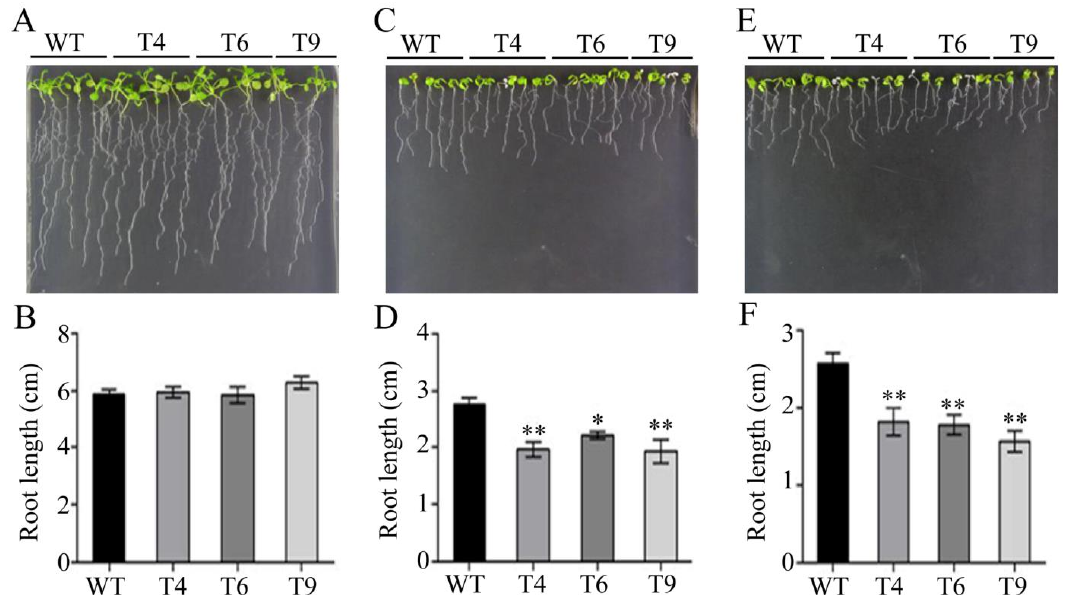
Figure 6. Root length of FtMYB22 transgenic Arabidopsis (T4, T6, and T9) lines and WT lines. ( A , B ) Root length under normal condition. ( C , D ) Root length under mannitol condition after 7 days. ( E , F ) Root length under salt condition after 7 days. WT, wild-type. Data are presented as mean ± SD and calculated from three independent experiments. Error bars represent standard errors. ** means extremely significant difference at p < 0.01 level, * means significant difference at p < 0.05 level.